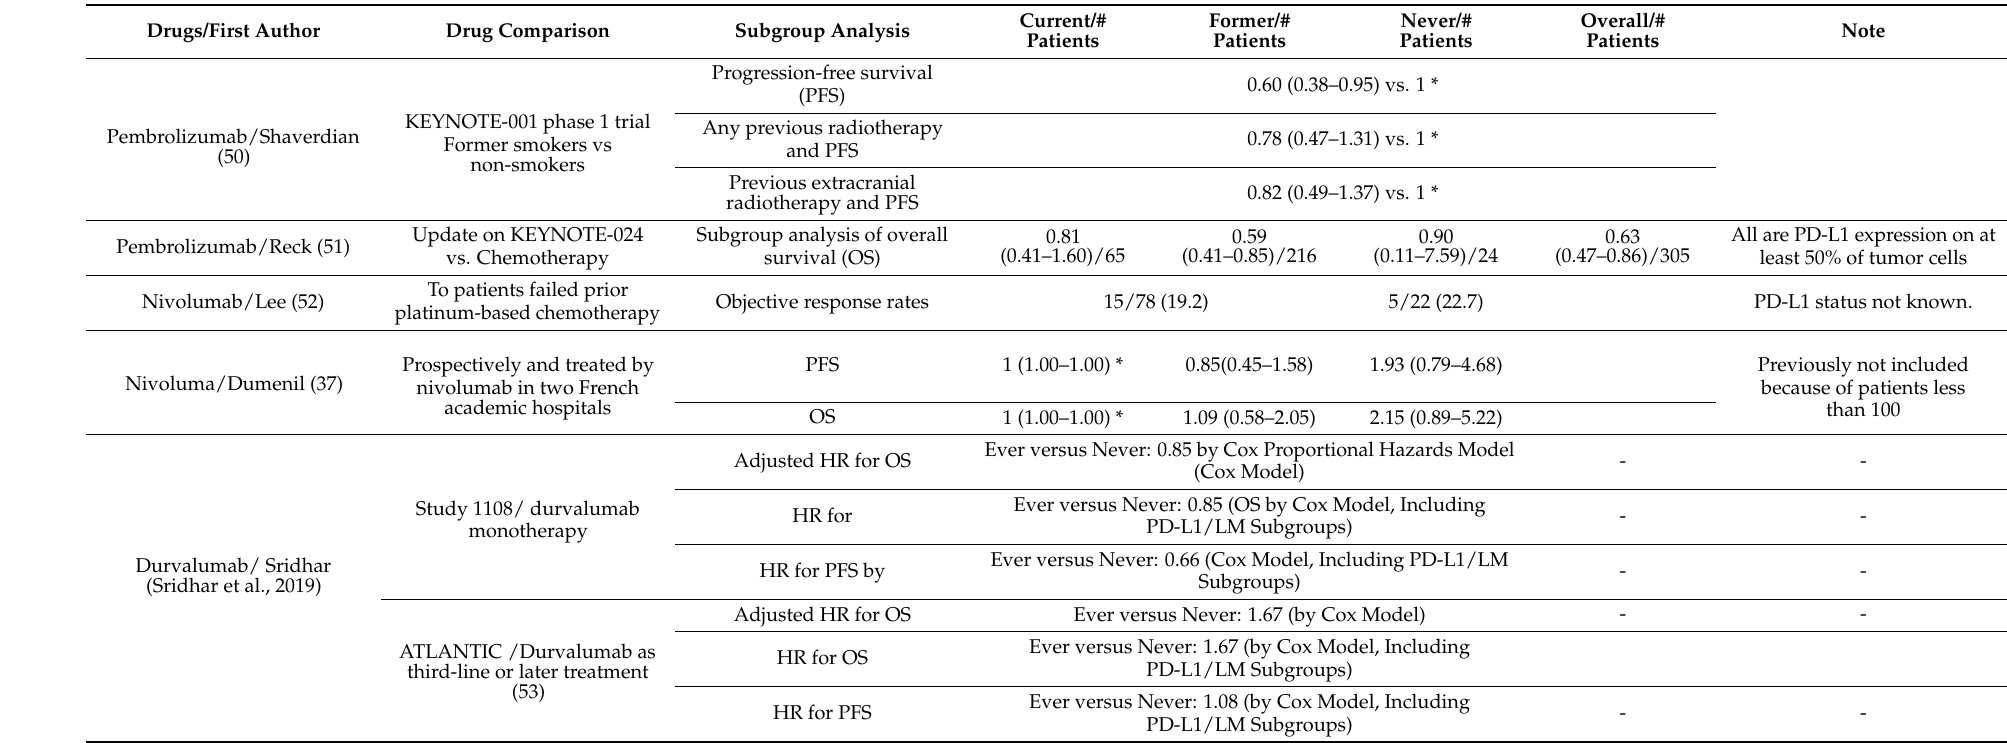
Table 1. Additional data collected from clinical